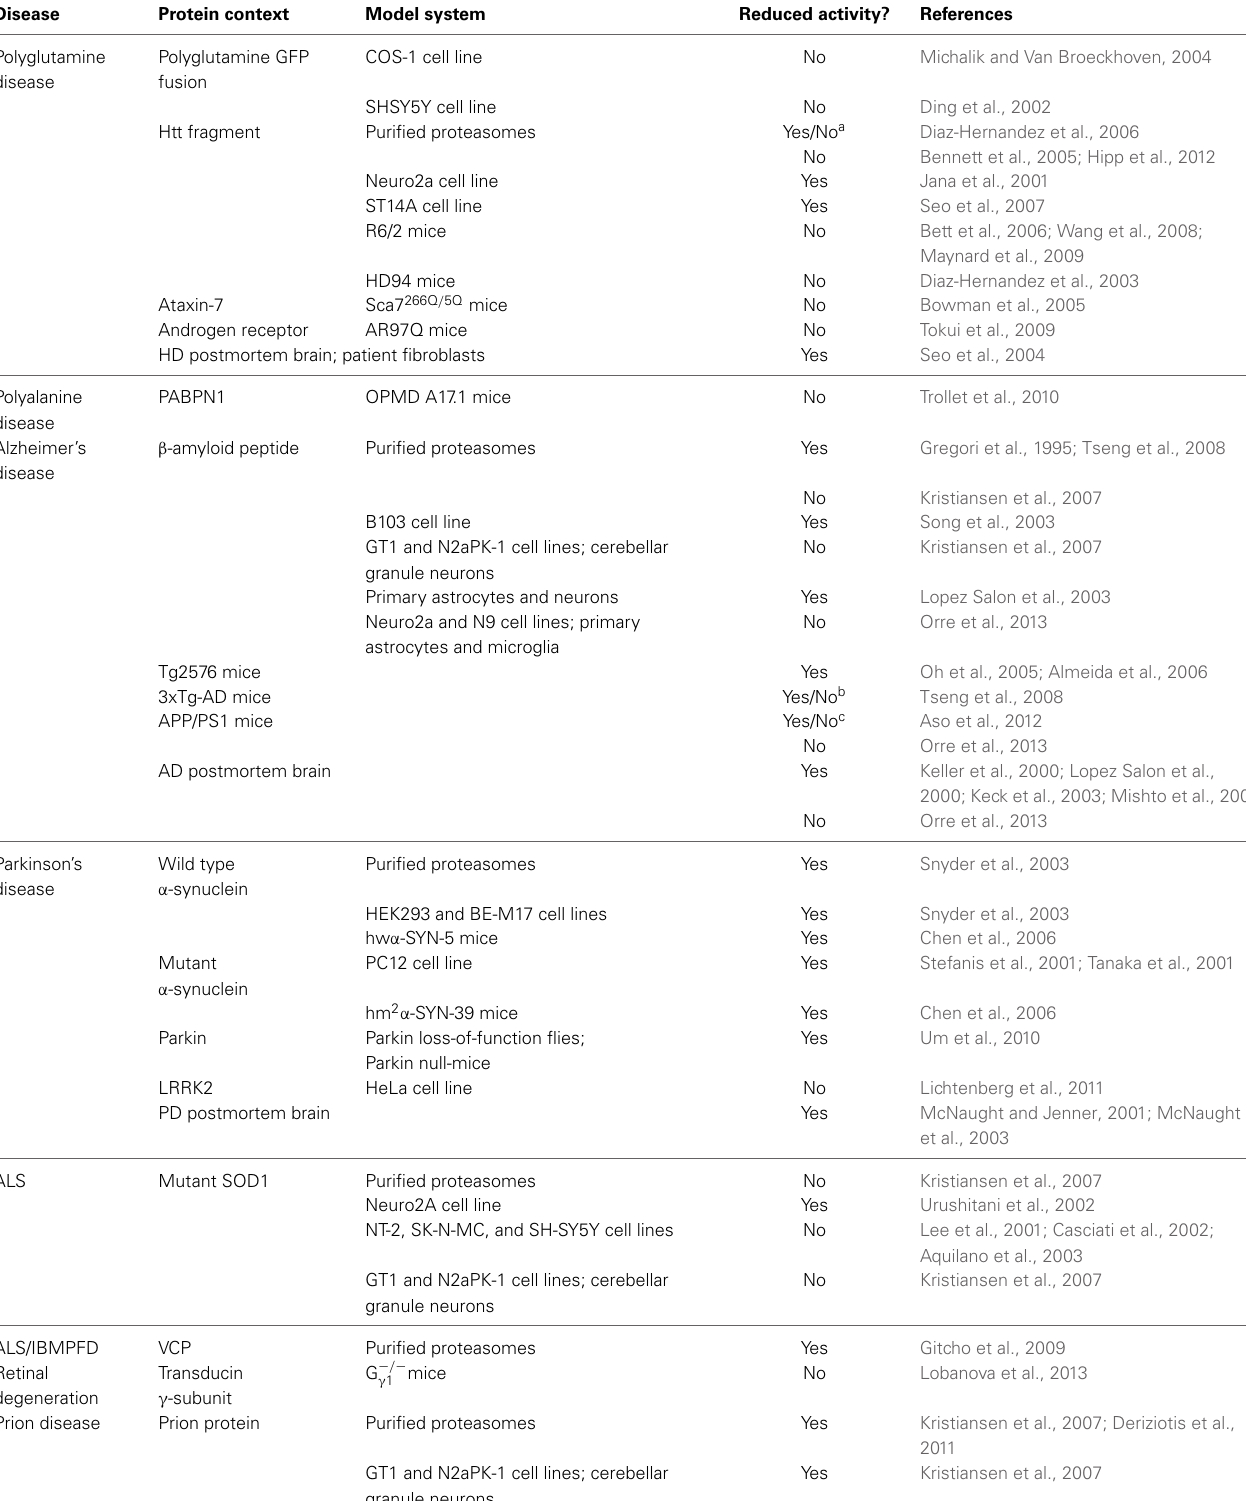
Table 1 | Overview of measurements of the proteolytic activity of the proteasome in neurodegenerative disease models. Disease